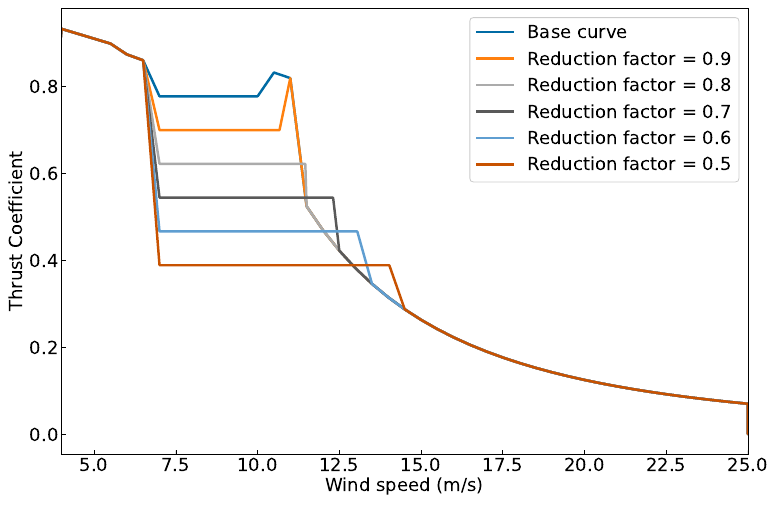
Figure 14. C T curves obtained for different levels of thrust reduction, compared against the base C T curve used in Case 0 and Case A.